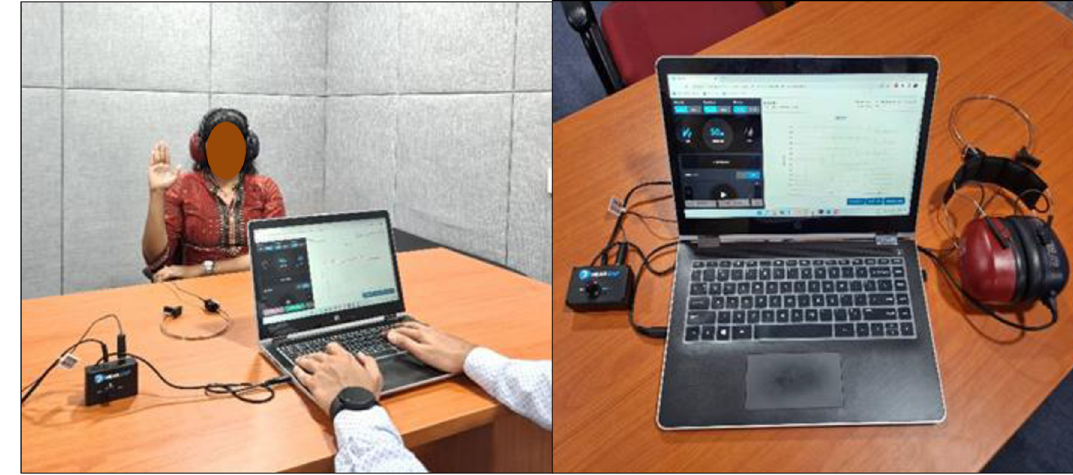
Fig 1. web-based audiometry testing on a laptop connected to transducers via a splitter. HEARZAP